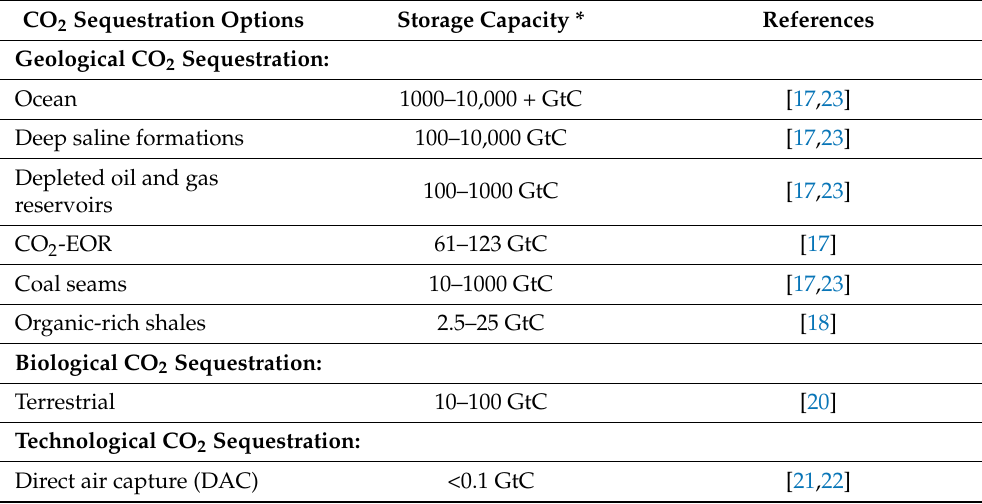
Table 1. Worldwide potential reservoir capacity for CO 2